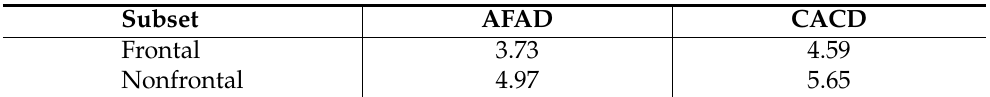
Table 2. Performance (MAE) comparison on the frontal and nonfrontal subsets of AFAD [12] and CACD.